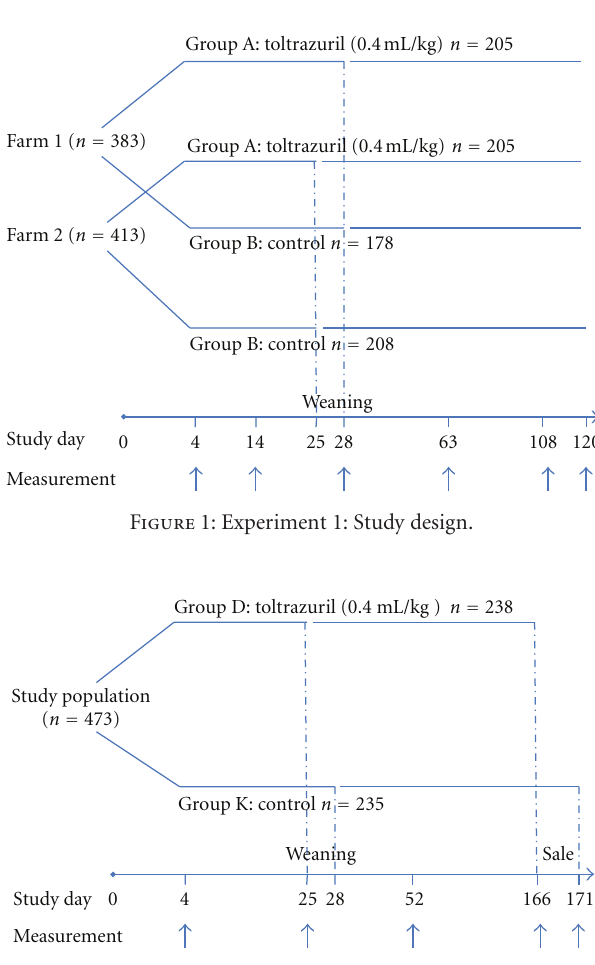
Figure 2: Experiment 2: Study